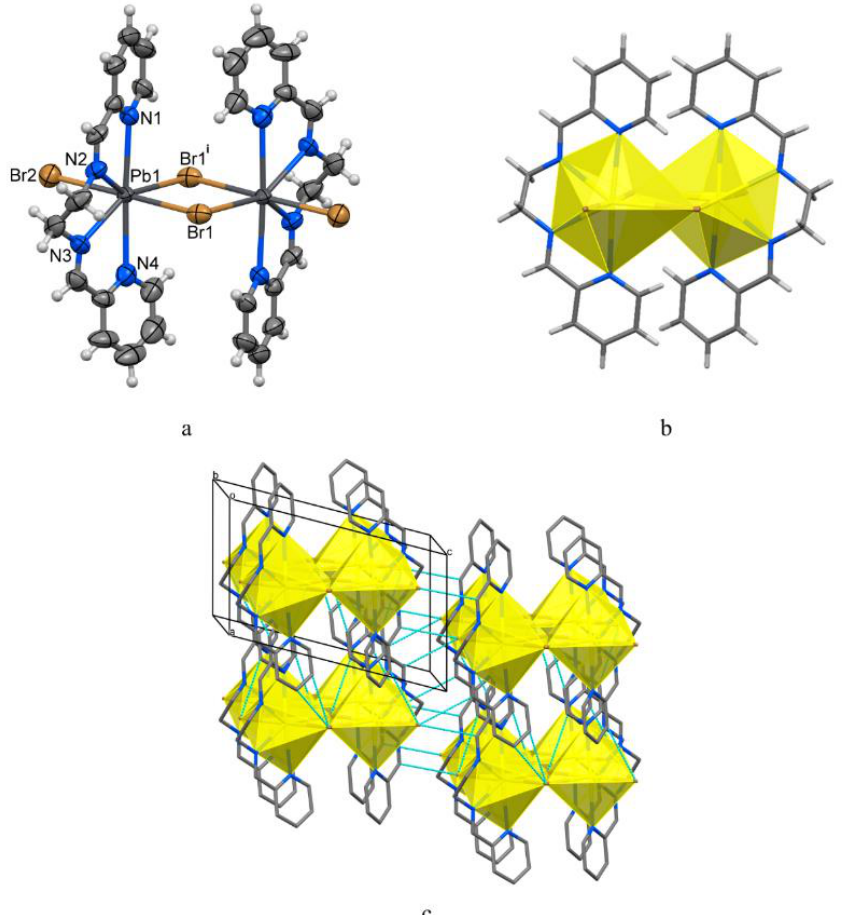
Figure 4. ( a ) Molecular structure and principal atom labelling of [PbBr 2 (L3)] 2 ( 3 ), ellipsoids are shown at the 50% probability level [symmetry code: i 1 − x , 1 − y , 1 − z ]; ( b ) the same molecule in a polyhedral form; ( c ) fragment of the 3D supramolecular network in 3 stabilized with C–H ··· Br hydrogen bonds (shown in blue, H atoms